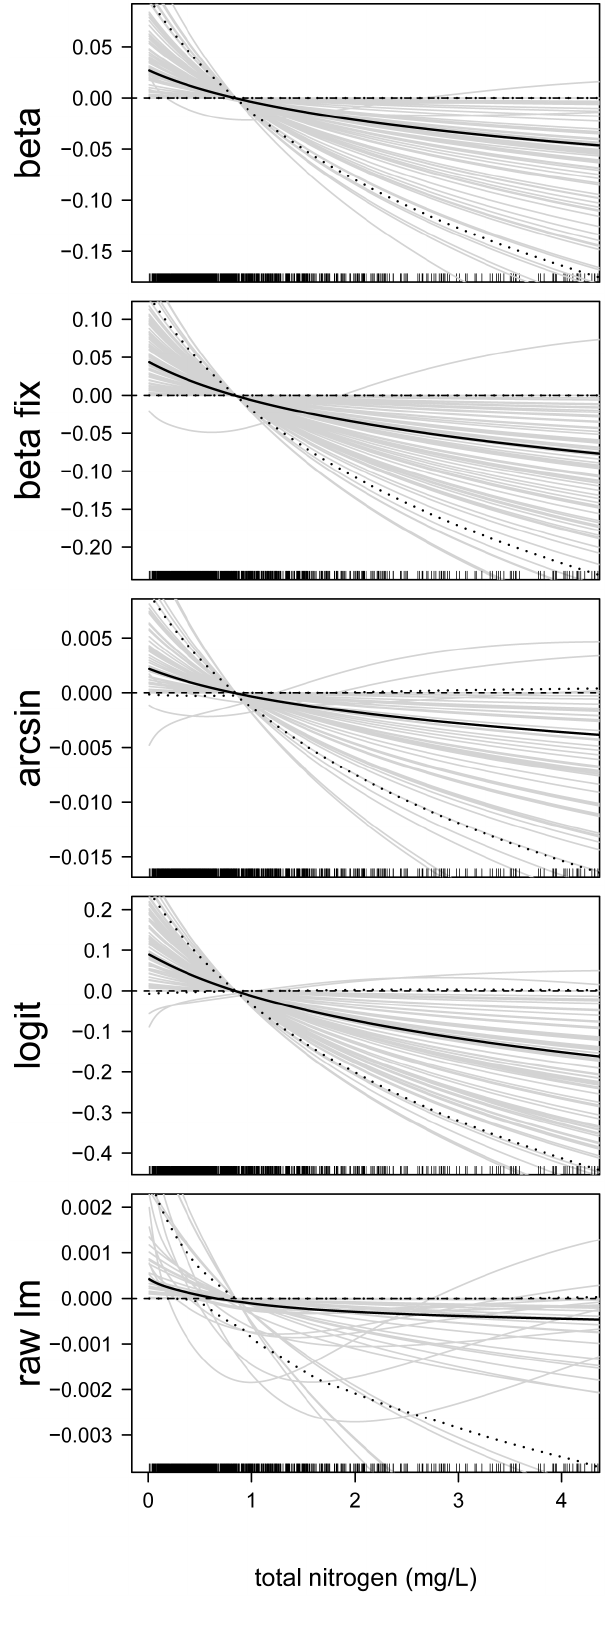
Figure 9. Function estimates for the total nitrogen concentra- tion. Analysis of the NLA Data. The five panels contain the function estimates for the total nitrogen concentration (computed from 100 bootstrap samples). In case of beta regression, estimates present the effects of the total nitrogen concentration on the mean parameter m . Black lines correspond to the mean and the 0.05 and 0.95 quantiles of the function estimates. For reasons of interpretability, the range of the x-axes was restricted to the lower 95% of the sample